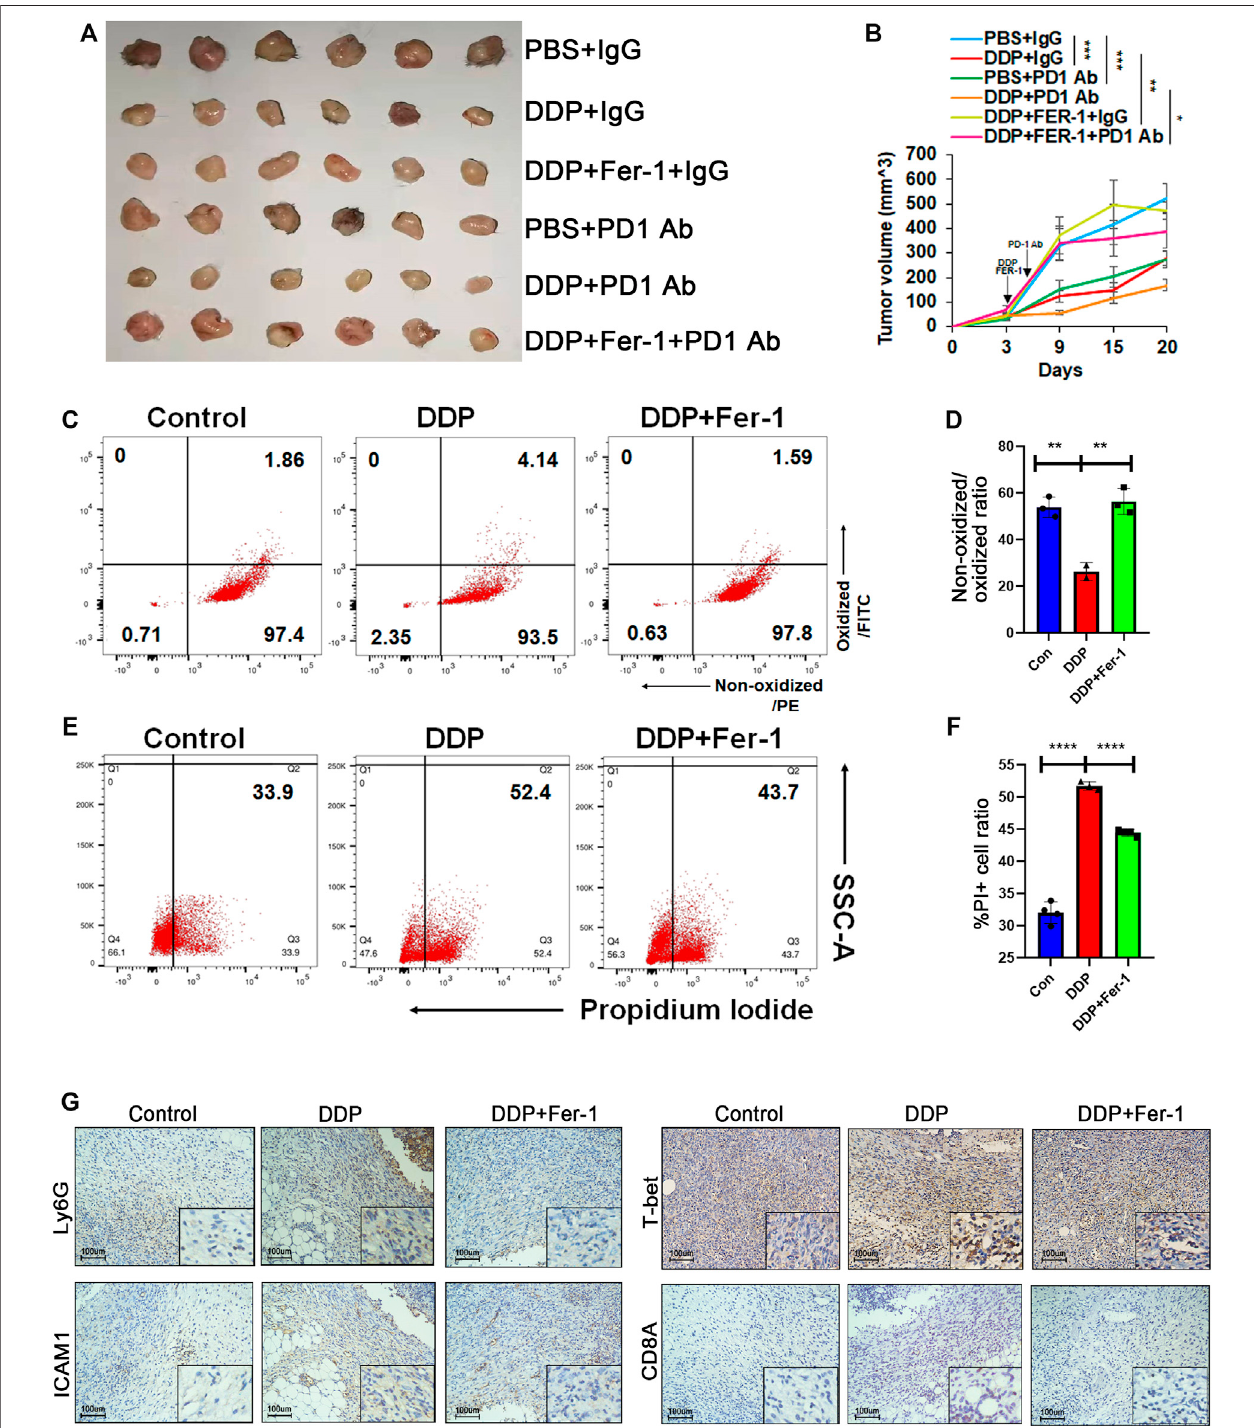
FIGURE 5 | Cisplatin-induced ferroptosis promoted ef fi cacy of ICI therapy in vivo. (A) and (B) Tumor image (A) and tumor growth (B) of Lewis lung cancer cell (LLC)-bearing C57 mice. When the tumor size was palpable, LLC xenografts were injected with DDP intraperitoneally (5 mg/kg once) and then treated with ferrostatin-1 (10 mg/kg once) or PBS on the same day. Anti-PD1 antibody was injected intraperitoneally the day after DDP or DDP plus ferrostatin-1 administration. Xenografts were harvested18 dayspostinjection. (C) and (D) Primarycellswereisolatedfromxenografts3 daysafterDDPorDDPplusferrostatin-1administration.DDPtreatment group showed increased lipid peroxidation while ferrostatin-1 rescued this effect. (E) and (F) PI staining of primary cells isolated from xenografts indicated that DDP increased cell death ratio while ferrostatin-1 rescued this effect. (G) Representative immunohistochemical images of paraf fi n-embedded xenograft sections. The DDP treatment group showed increased Ly6G and ICAM1 level, which indicated N1 neutrophils. T-bet and CD8A, representing Th1 cells and CD8 T cells, respectively, were also upregulated. Bar graphs represent the mean ± SD of indicated samples. p p < 0.05, pp p < 0.01, ppp p < 0.001.